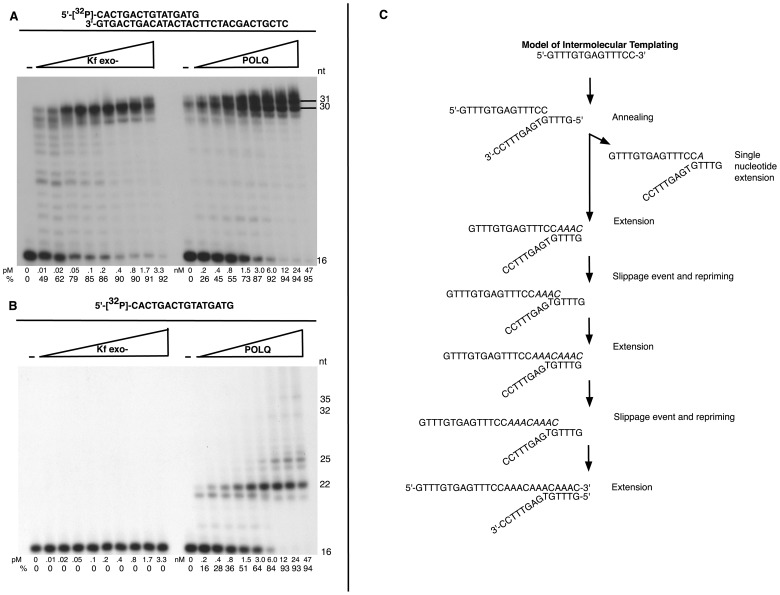
Unique template dependent DNA polymerase activity of POLQ.Exonuclease-defective E. coli pol I Klenow fragment (Kf exo-) or POLQ was incubated at the indicated protein concentrations with (A) a 5′-32P-labeled primer 16-mer and 30-mer complementary template, (B) 5′-32P-labeled 16-mer primer and no template. All reaction mixtures included all four deoxynucleotide triphosphates and were incubated at 37°C for 10 min (A) or 20 min (B). The first lane contained no enzyme. The percentage (%) of the primer extended is shown below each lane. (C) Model of intermolecular templating performed by POLQ in the process of extending a different single-stranded oligonucleotide, used to produce the data in Table S1. This model depicts a 12 nt extension product in Table S1. The product can be produced by a series of annealing, extension, slippage and repriming events.